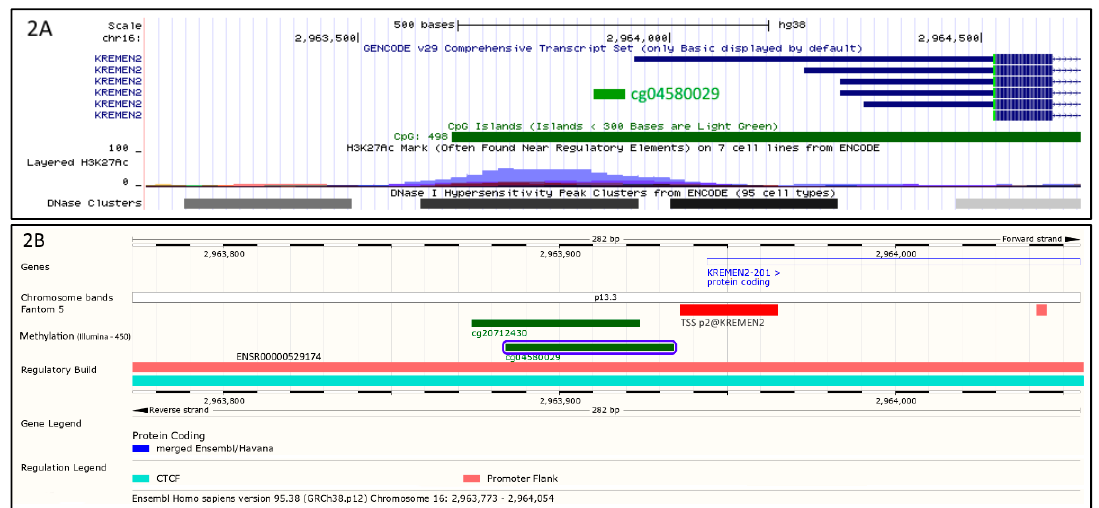
Figure 2. Environment of cg04580029 probe. As depicted by figures 2A and 2B, cg04580029 (in green) is located on the chromosome 16p13.3 upstream of KREMEN2 gene. ( A ) shows that cg04580029 is located in a regulatory element, indicated by acetylation of histone 3 on lysine 27 (H3K27Ac peak, in violet). Furthermore, DNase I hypersensitivity peak clusters (black and grey rectangles) reveal the presence of an accessible chromatin zone which is the sign of a transcriptional activity. ( B ) confirms that cg04580029 is located within a regulatory zone (promoter flank ENSR00000529174, in light red) and shows in addition that 3 base pairs away is located the transcription start site of KREMEN2 gene, p2@KREMEN2.